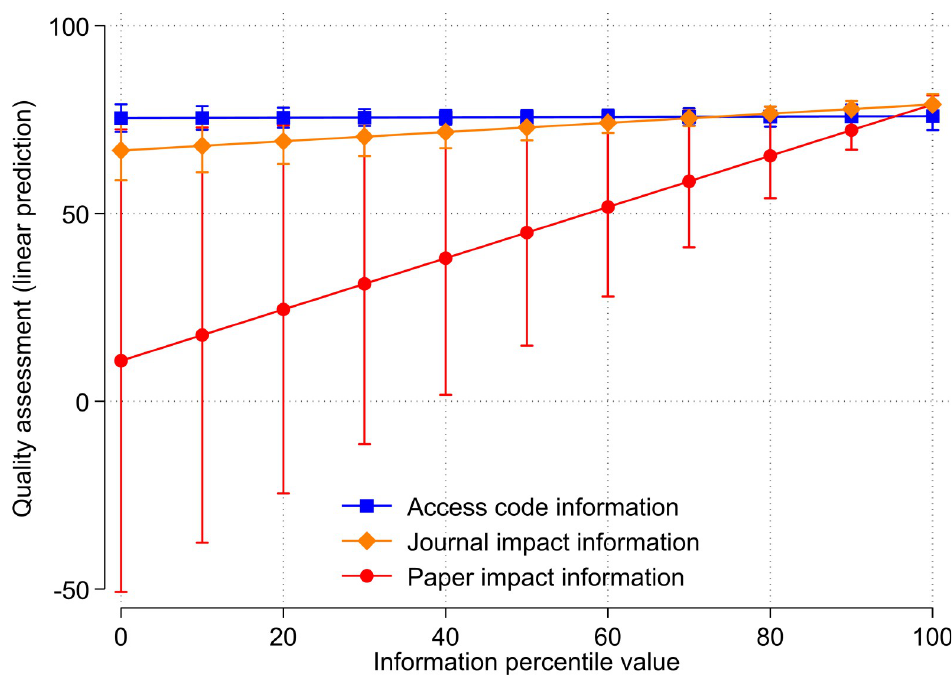
Fig 2. Relationship between treatments (access code, journal impact information, and paper impact information) and quality assessment by respondents.